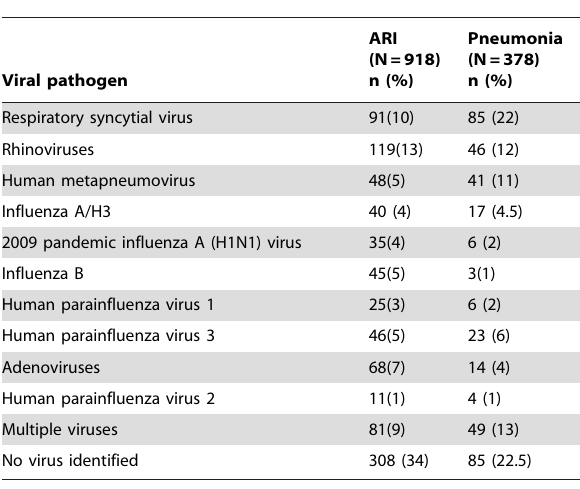
Table 2. Frequency of respiratory viral pathogens in episodes of respiratory symptoms (N =1,322) in a low income urban neighborhood, Dhaka, Bangladesh (April 2009–March